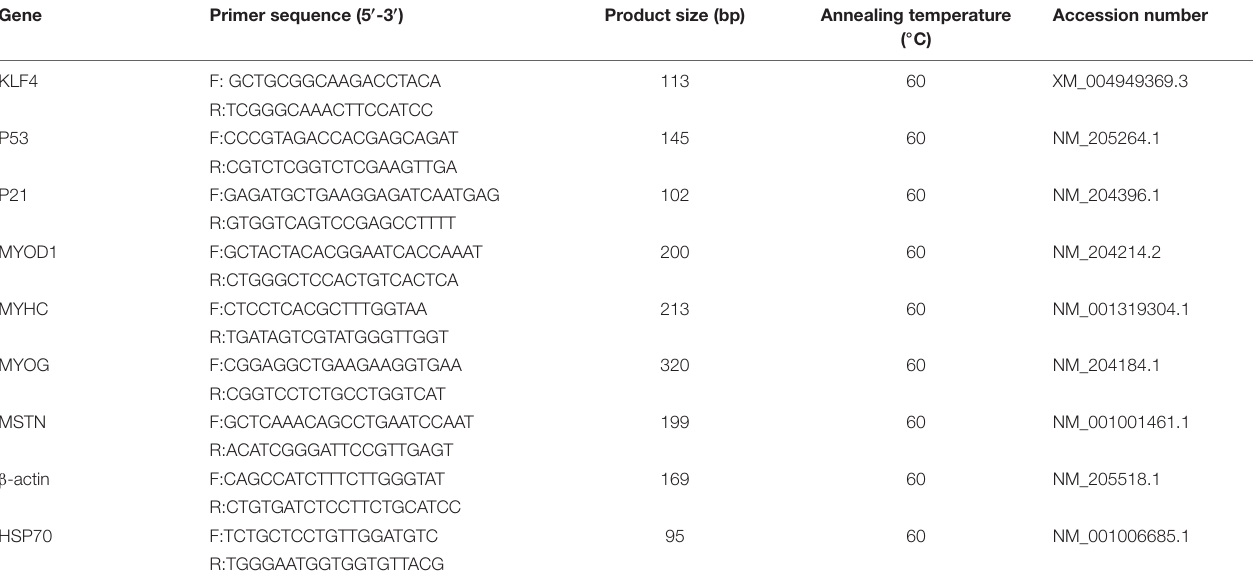
TABLE 2 | Gene primers used for qRT-PCR. Gene Primer sequence (5 (cid:48) -3 (cid:48) ) Product size (bp) Annealing temperature